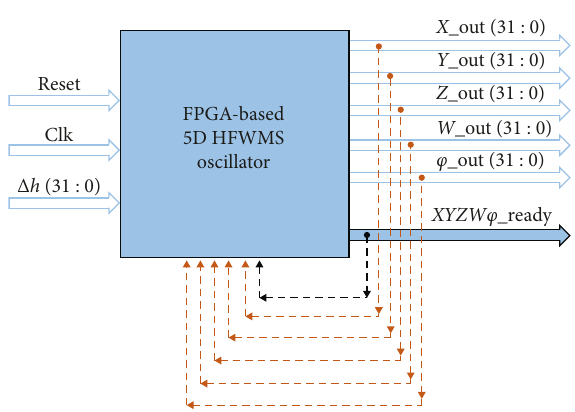
Figure 10: The top-level block diagram of the FPGA-based 5D